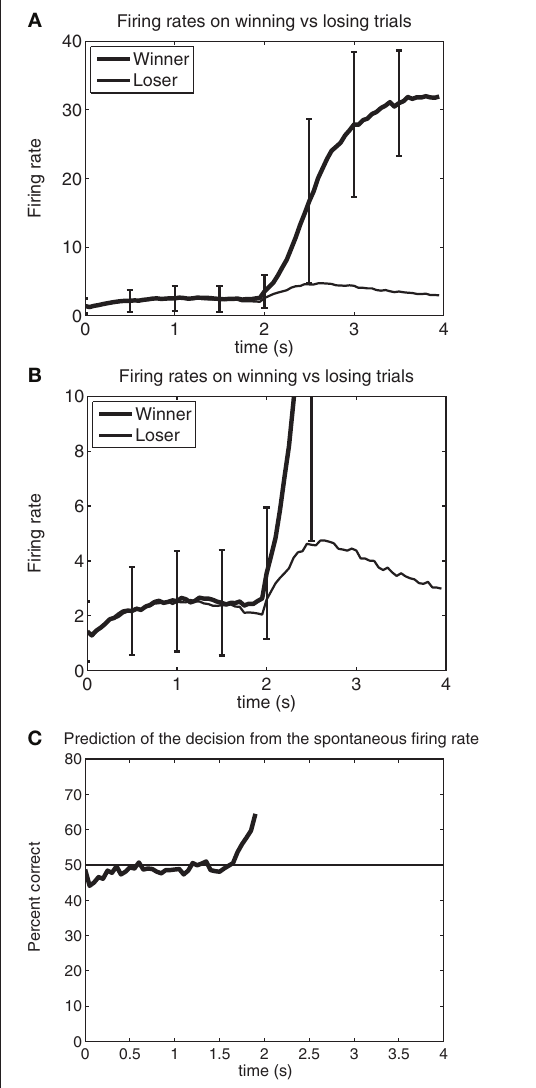
that the difference in the firing rates of the pool that will win and of the pool that will lose can be illustrated. (C) The prediction accuracy of which pool will win from 100ms periods of the firing of the two pools at different times before the decision cues are applied at t = 2s. The network size was 500 neurons, with 400 excitatory neurons, 400 excitatory recurrent collateral synaptic connections on each neuron, and 40 neurons in each of the two decision pools. (D) Example from a single trial of the firing rates of the four populations of neurons for a correct decision (for which (cid:2) I = 16). From the top right the plot order is: D1 is the firing rate of the correct and winning attractor D1. Inh is the inhibitory population that uses GABA as a transmitter. NSp is the non-specific population of neurons (see Figure 1 ). D2 is the firing rate of the correctly losing attractor D2. (E) . Rastergrams for the same trial shown in d to illustrate the probabilistic spiking of each neuron. Ten neurons from each of the four pools of neurons are shown. Each vertical line is the spike from a neuron [After Rolls and Deco